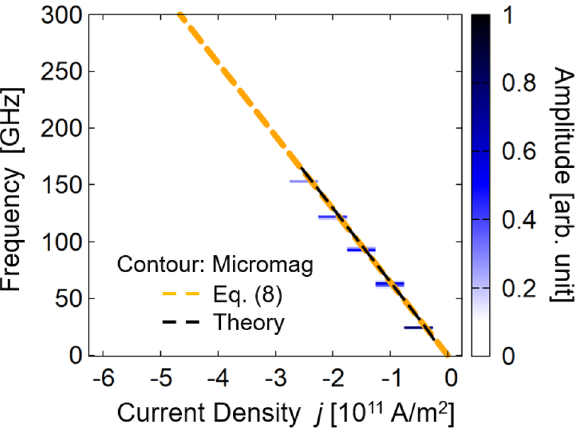
Figure 6. Current dependence of Fourier spectrum (contour), f estimated from Eq. (8) (orange broken lines), and analysis including magnetic anisotropies (black broken lines), with J 1 = 0.6 mJ/m 2 and J 2 = −0.6 mJ/m 2